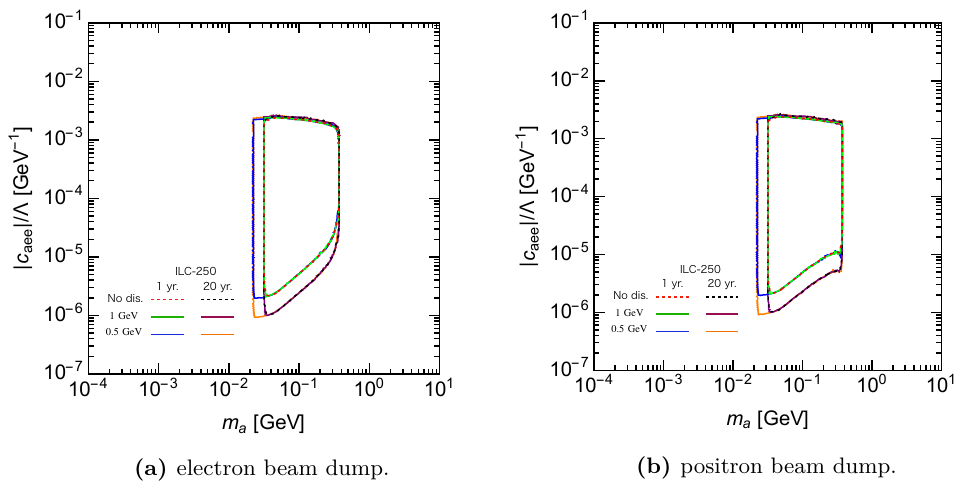
Figure 10. The red and black dotted lines show the bounds of sensitivity ILC-250 at 95% C.L. with 1- and 20-year statistics without the effect of the angular distribution of incident positrons. The green and purple solid lines are the same bounds as the red and black dotted lines but the angular distribution of incident positrons and E th = 1 GeV are included. Note that the red and black dotted lines almost overlap the green and purple lines and cannot be distinguished. The blue and orange solid lines are the same bounds as the green and purple solid lines but for E th = 0 . 5 GeV